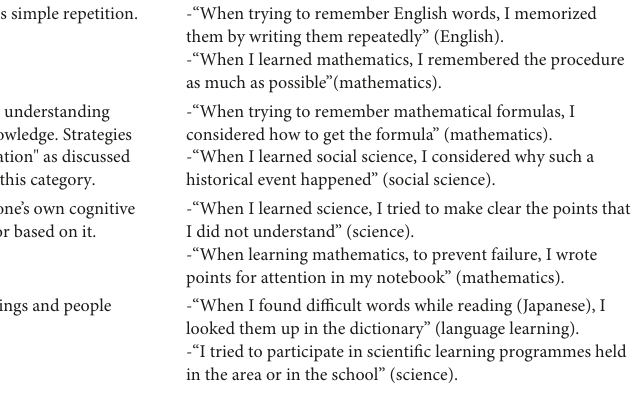
TABLE 2 Subcategories, definitions, and examples of items used in this study. Subcategories